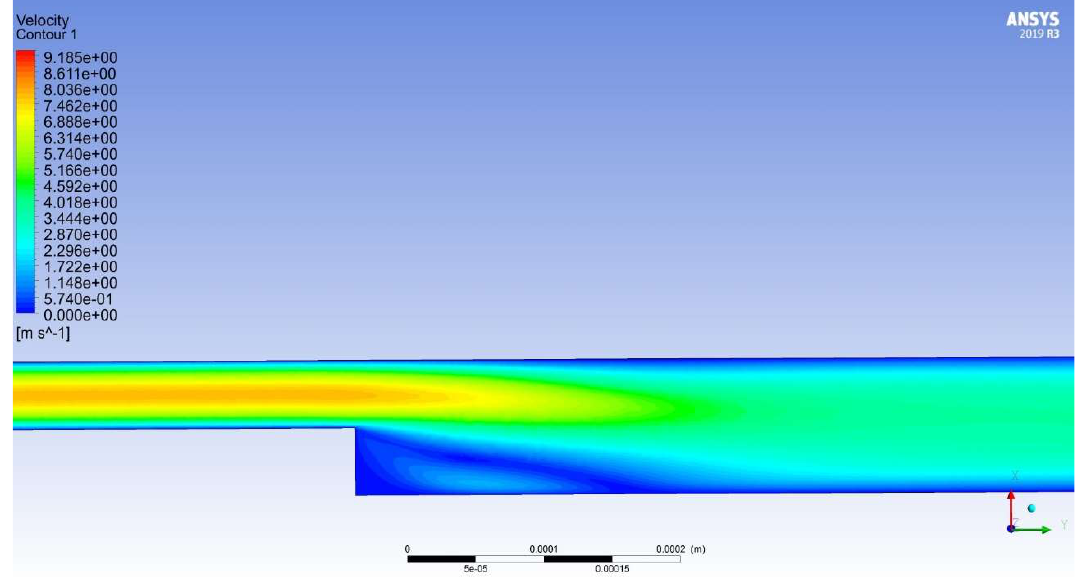
Figure 16. Velocity distribution in the turbulence model Standard k-epsilon.